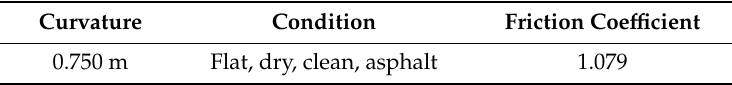
Figure 6. Vehicle trajectory during road test. Table 3. Road conditions during real vehicle